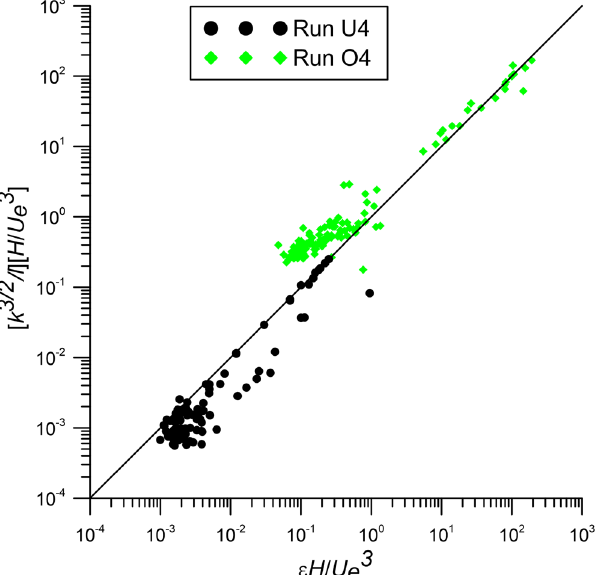
Figure 11. Estimates of dissipation rate of the cross section at x / D = 26.67 from the jet nozzle (based on the scaling l ~O( H ) for run U4 and on l ~O( d ) for run O4) with the observed dissipation rate ε